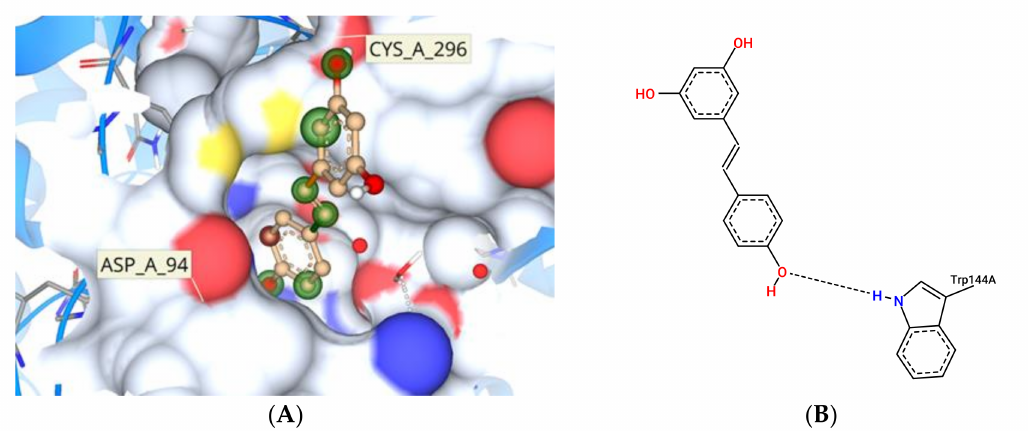
Figure 19. Resveratrol bound to SrfJ protein. ( A ) Three-dimensional depiction of the interaction very limited key amino acids. ( B ) Two-dimensional depiction of the protein–ligand interaction highlighting the amino acids with hydrogen bond